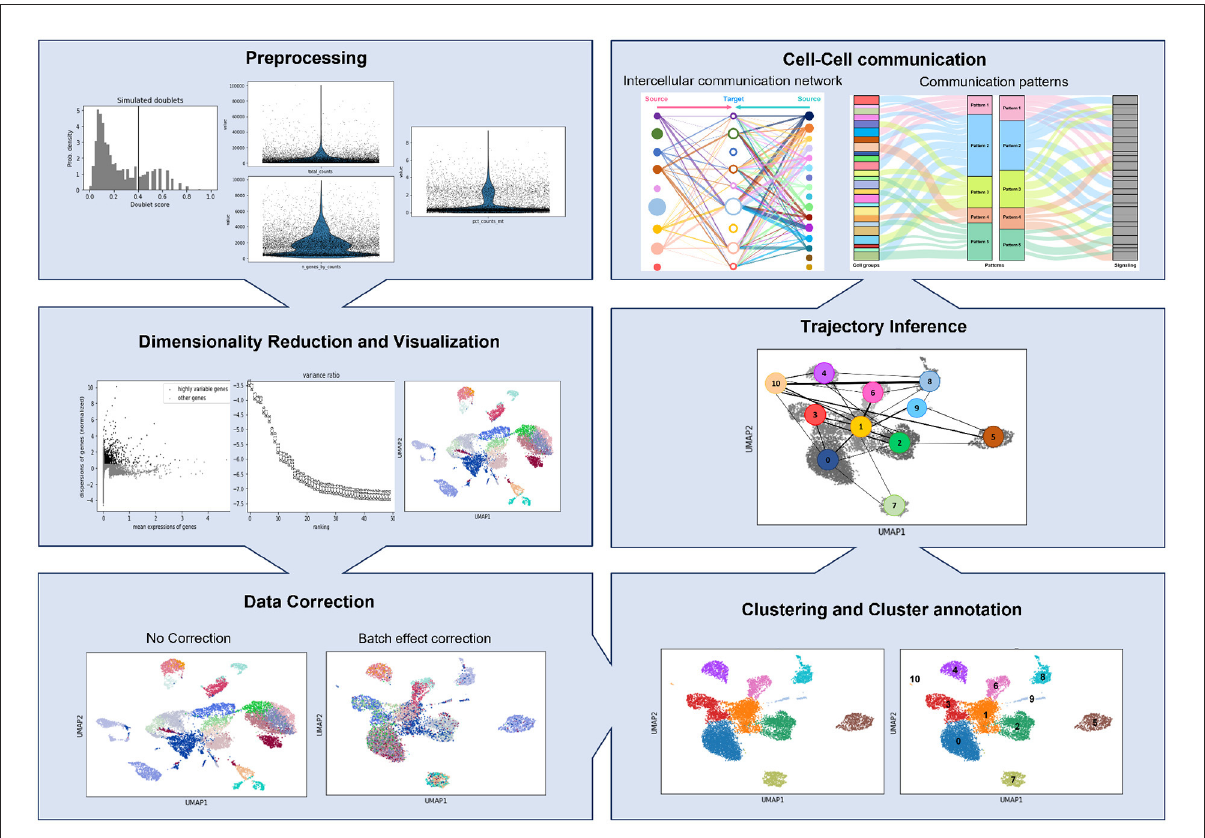
FIGURE1 Schematic representation of a scRNA-seq pipeline, showing the outputs of each step stated in this review.